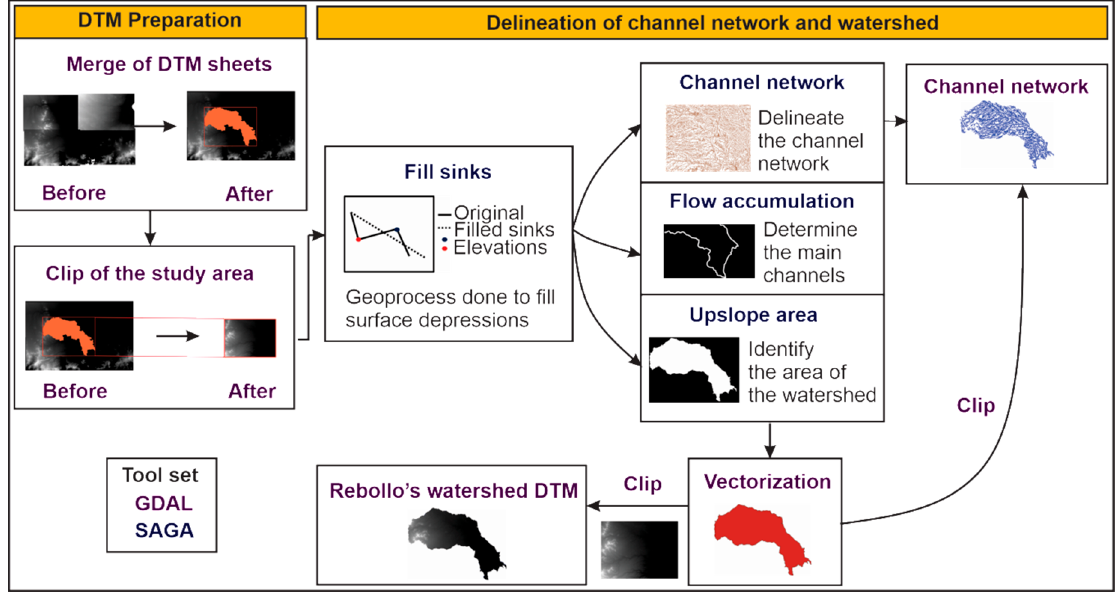
Figure 4. Geoprocess to delineate and describe the channel networks and watershed.